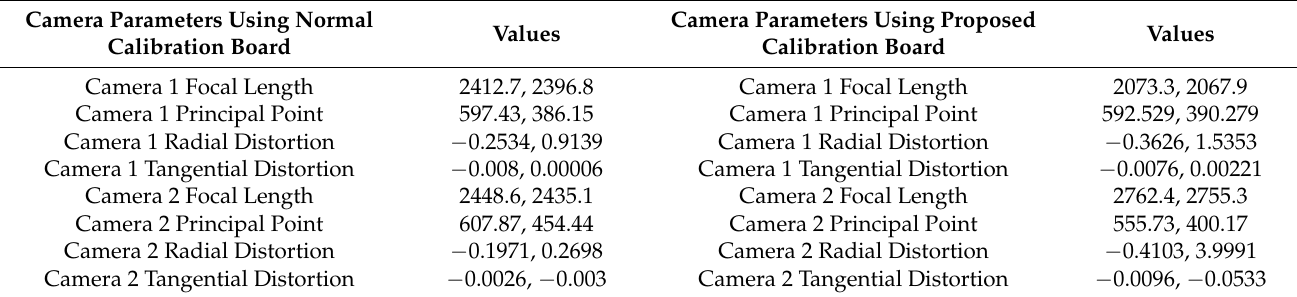
Table 1. Camera parameters using normal checkerboard and the proposed calibration board. Camera Parameters Using